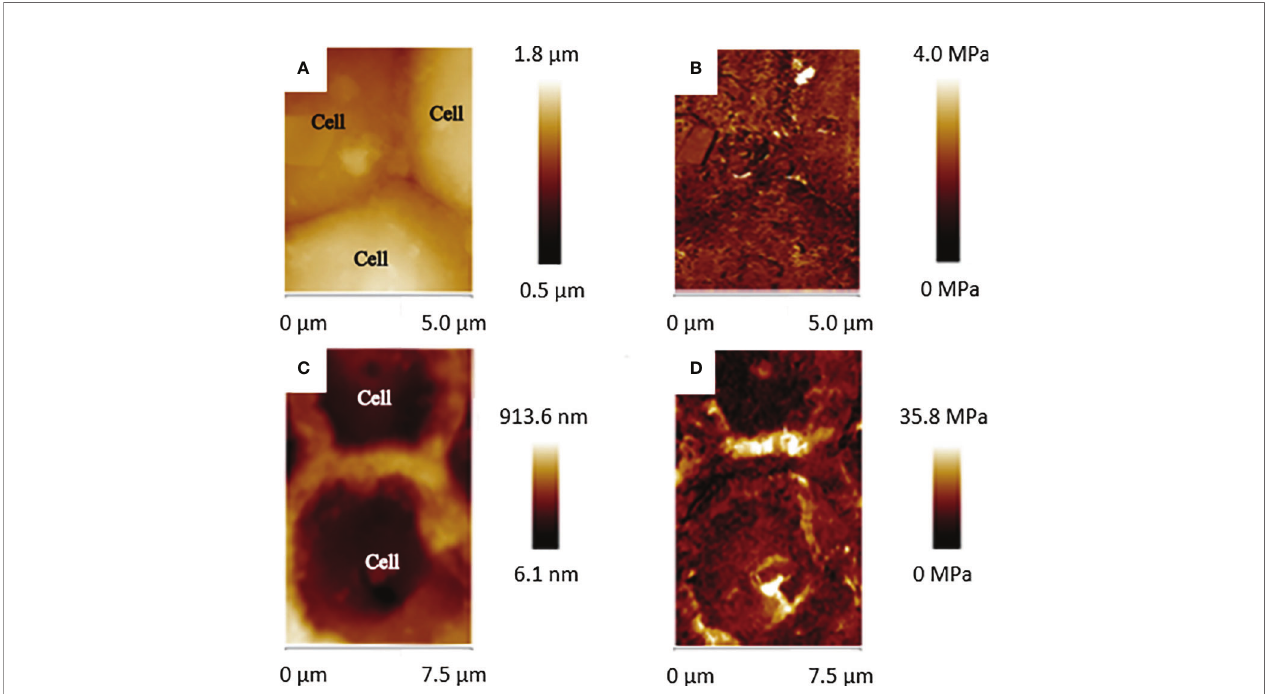
FIGURE 4 | Topographical and elasticity images of 4 cells (A, B) and 16 cells (C, D) showing the topographical and hardness (DMT Modulus) differences of the cell surfaces between these two developmental